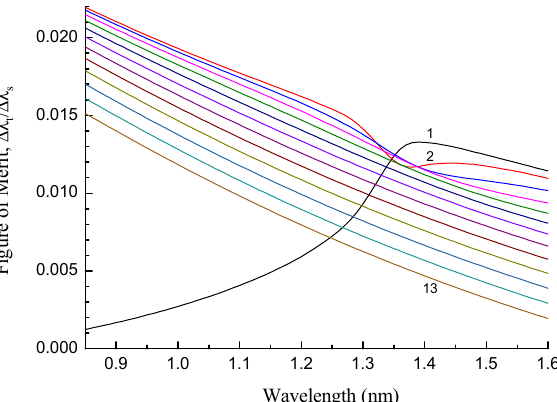
Figure 11. Figure of merit for different cladding modes of a grating with a length of 20 mm in SMF-28 fiber as a function of wavelength for ∆ T = − 10K (300–290 K).